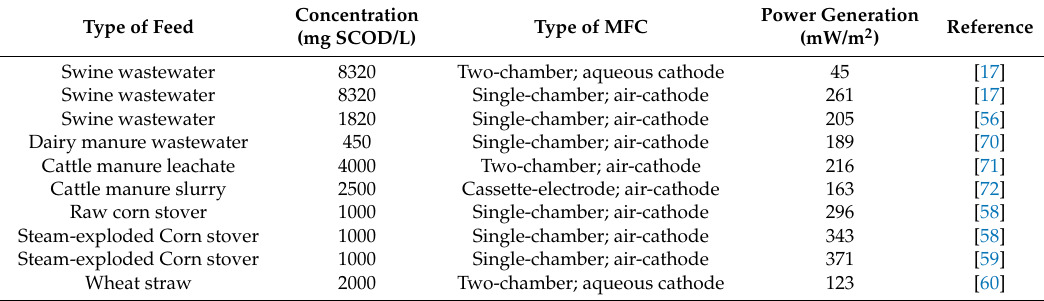
Table 2. Electric power generation in microbial fuel cells (MFCs) using different types of agricultural